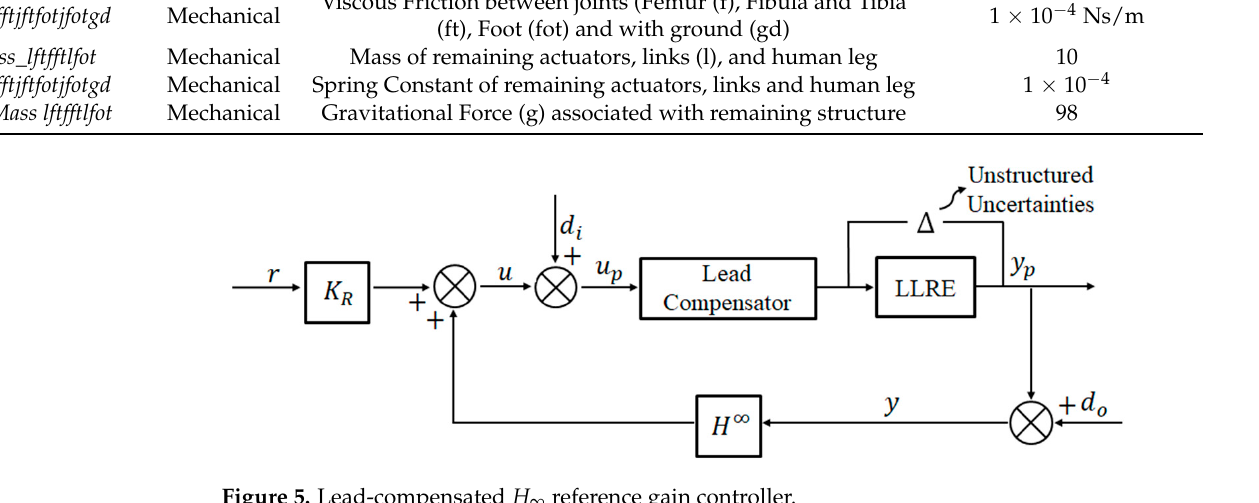
Figure 5. Lead-compensated 𝐻 (cid:2998) reference gain controller.